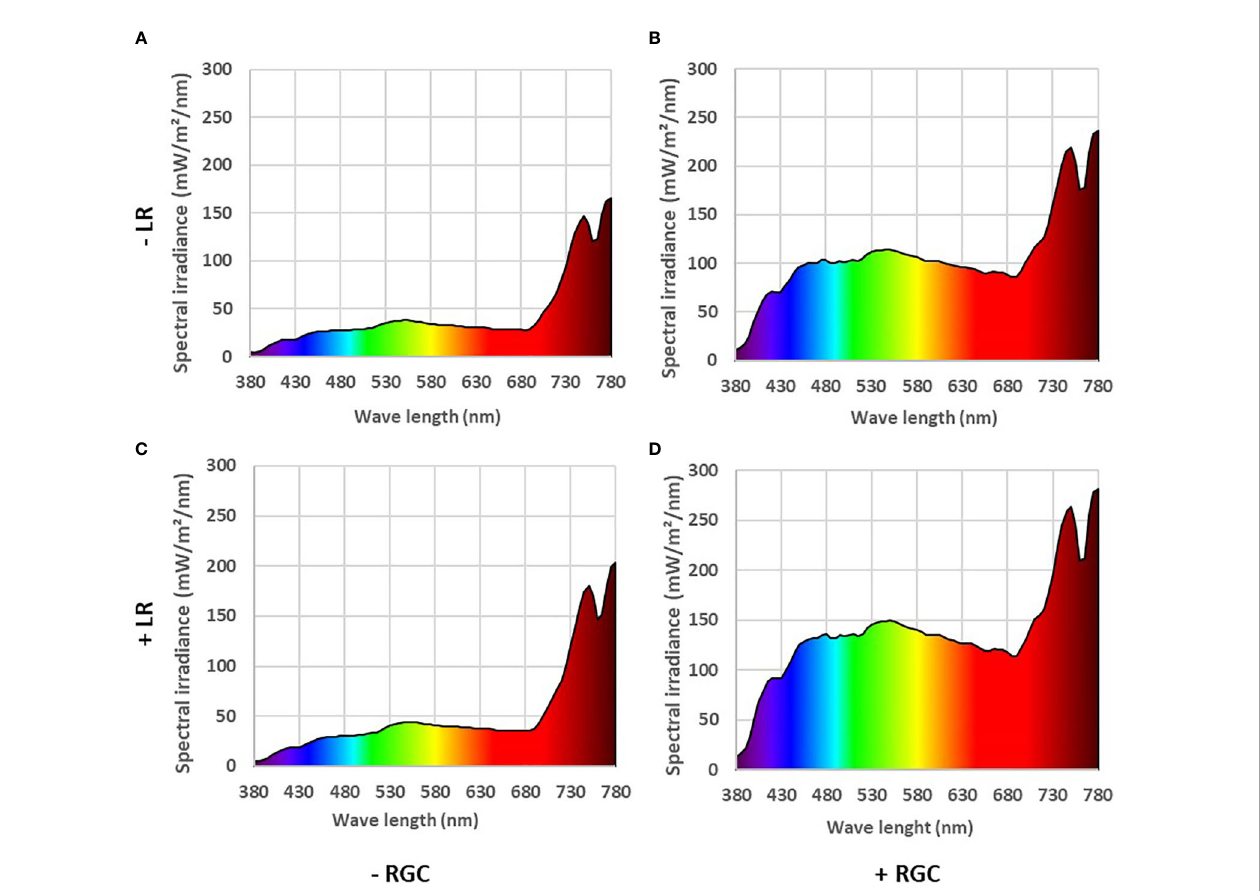
FIGURE 1 The re fl ected light spectrum measured at the cluster zone in 2019 as affected by using (+) (B, D) or without using (-) (A, C) light-re fl ective ground cover (RGC). Treatments have been conducted with (+) (C, D) or without (-) (A, B) cluster-zone leaf removal (LR). Values are the mean of four readings. Data were recorded once at the mid-day of June 17th,